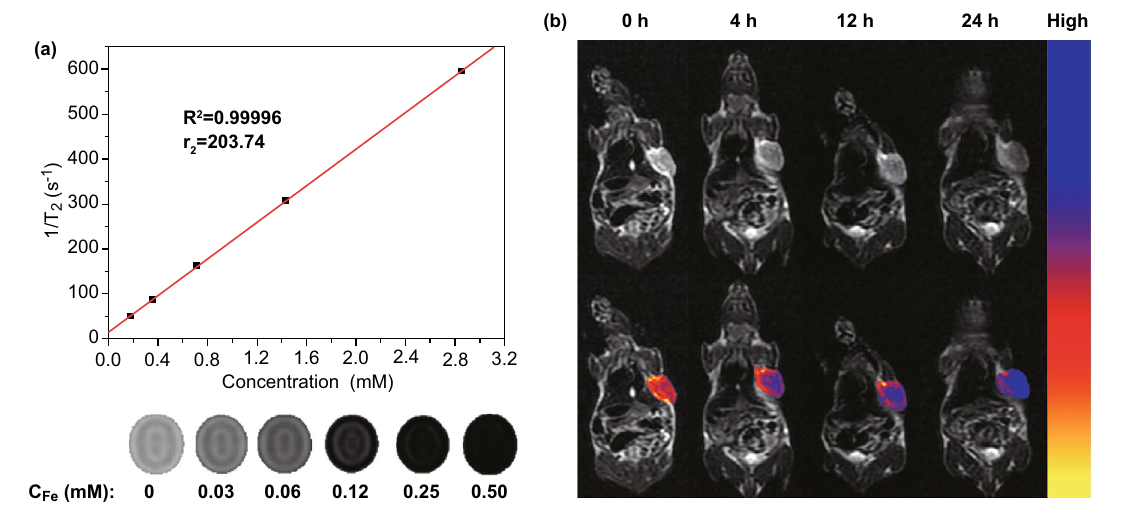
Fig. 6 a T 2 -weighted MR images and T 2 relaxation rates ( r 2 ) of FeO/MoS 2 -BSA nanocomposites. b Magnetic resonance imaging of tumor bear- ing mice and pseudo color imaging of tumor after tail vein injection for 0, 4, 12, and 24 h in